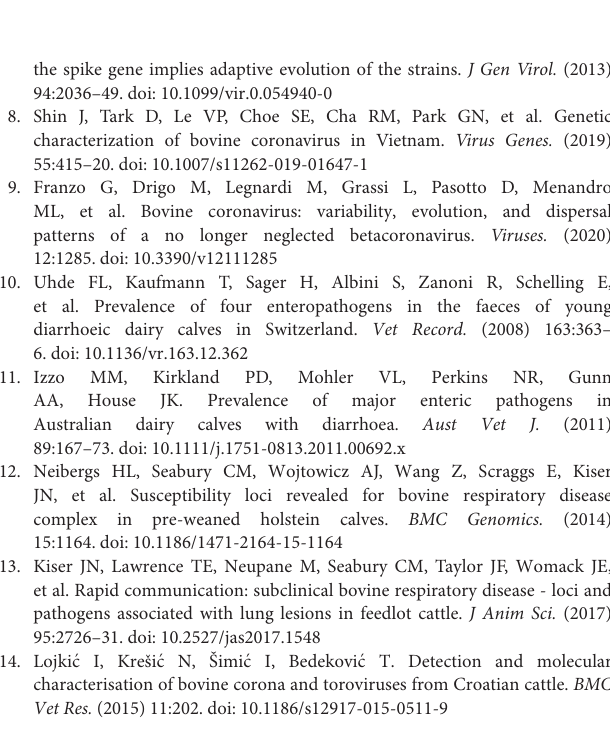
Supplementary Figure 1 | Example of the McGuirk scoring system used to classify cattle as bovine respiratory disease cases and controls. Supplementary Table 1 | Significant loci associated with bovine coronavirus infection in a dairy, a feedlot, and a combined dairy and feedlot population. Supplementary Table 2 | Significant loci associated with bovine coronavirus and bovine respiratory disease infections in a dairy, a feedlot, and a combined dairy and feedlot